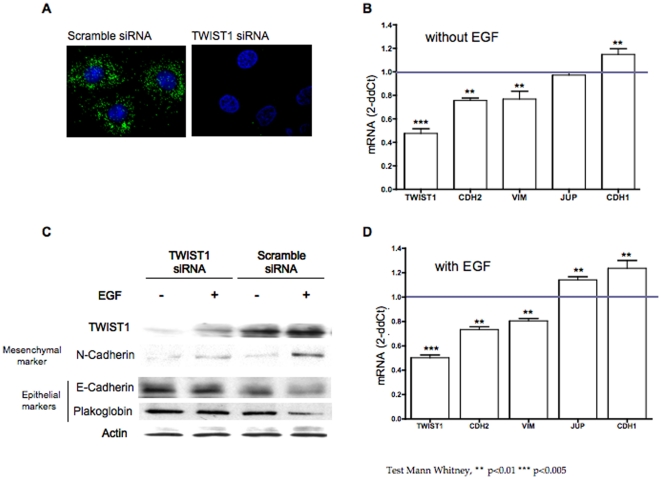
TWIST1 depletion through RNA interference overrides EMT induction by EGF in H1650 cells.
EGFR mutated, TWIST1 expressed H1650 human lung cells were depleted of TWIST1 through RNA interference. Impact of TWIST1 depletion on epithelial and mesenchymal markers in absence or in presence of EGF was examined. A. The efficiency of the siRNA was controlled by assessing TWIST1 expression by immunofluorescence. B. Expression analysis of TWIST1, CDH2, VIM, CDH1 and JUP in absence of EGF treatment by quantitative RT-PCR. Graph shows the relative expression (siRNA TWIST1/siRNA scramble) for the 5 markers. Each column represents the mean ±SD of 3 independent experiments each one done in triplicate. C. Impact of TWIST1 depletion on TWIST1, CDH2, CDH1 and JUP protein expression in H1650 cells in absence or in presence of EGF as assessed by western blotting. D. Impact of TWIST1 depletion on TWIST1, CDH2, VIM, CDH1 and VIM following cell treatment with EGF as assessed by relative expression (siRNA TWIST1/siRNA scramble). Each column represents the mean ±SD of 3 independent experiments each one done in triplicate.